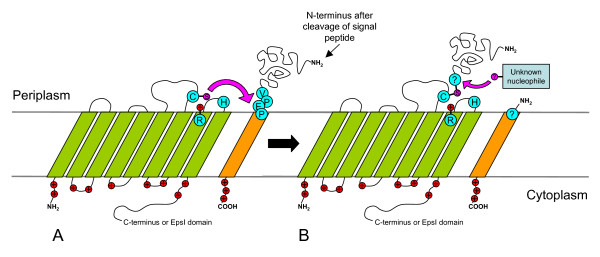
Proposed model of PEP-CTERM domain protein processing by EpsH. A) The PEP-CERM domain protein (orange) first is targeted to the inner membrane by its N-terminal signal peptide. Cleavage of the signal peptide by signal peptidase leaves the protein anchored by its C-terminal transmembrane helix. The PEP motif is predicted to lie at the membrane-periplasm interface where it is recognized by and binds to EpsH (green) adjacent to a catalytic triad on its periplasmic surface. Both the PEP-CTERM domain and EpsH are oriented in the membrane by their asymmetrical positive charge distribution (red). The cysteine sulfur nucleophile (purple) cleaves the bound PEP motif at an unspecified location. B) The covalently linked protein is subsequently transferred to an unknown periplasmic nucleophile (blue), likely destined to cross the outer membrane for incorporation into the exopolysaccharide layer.